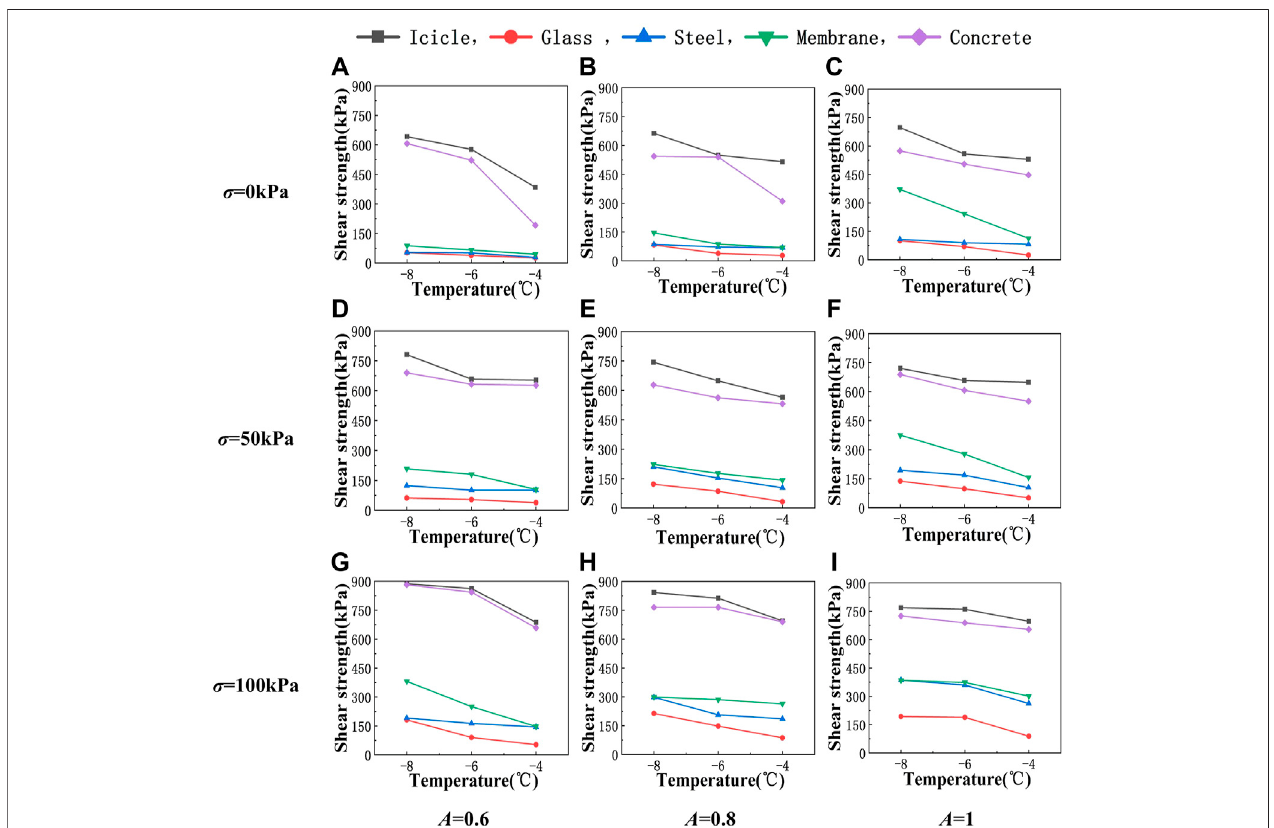
FIGURE 9 | Variation of the shear strength with temperature: row 1 (A – C) σ = 0 kPa, row 2 (D – F) σ = 50 kPa, row 3 (G – I) σ = 100 kPa, column 1 (A,D,G) A = 0.6, column 2 (B,E,H) A = 0.8, and column 3 (C,F,I) A = 1.